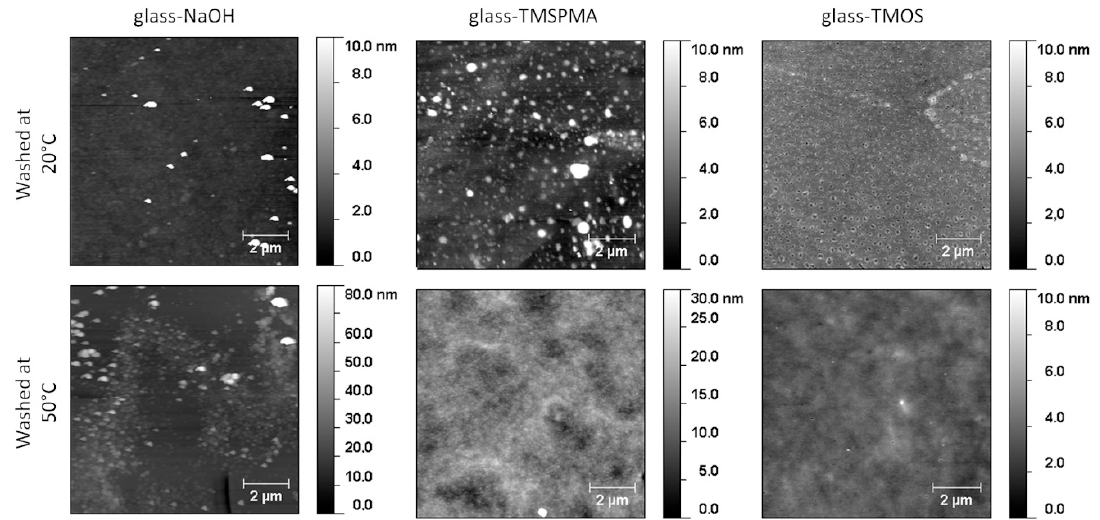
Figure 5. AFM images of PNIPAm a films spin-coated on glass-OH, glass-TMSPMA and glass-TMOS